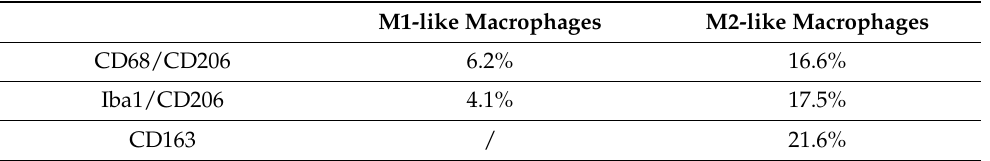
Table 2. Quantification of M1-like and M2-like macrophages in the regeneration region of the operated femur (quantitative analysis, based on random examination of 1000 cells in each of the